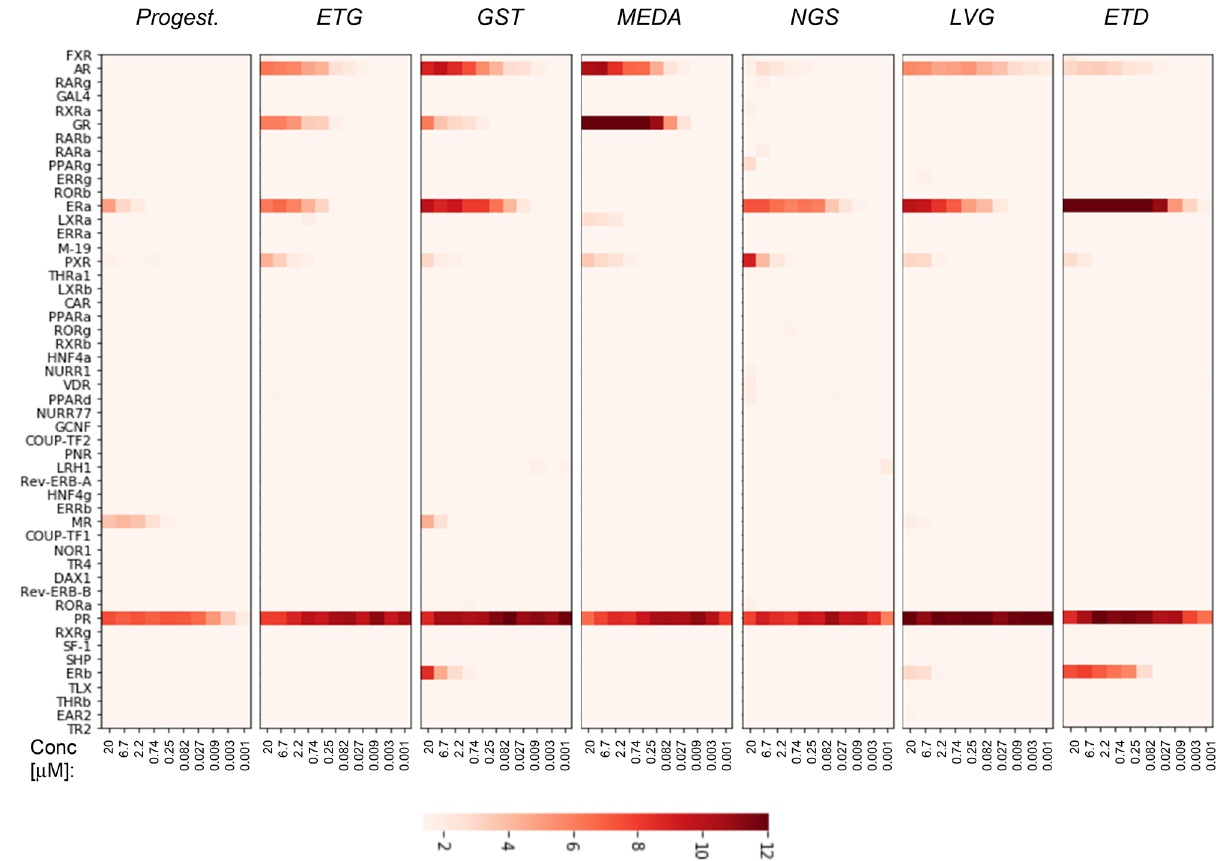
Figure 5. Assessing the polypharmacology of progestins. The heatmap shows NR activity profiles for progestins after a 24 h incubation with indicated concentrations. The fold-induction NR activity values in progestins vs. vehicle-treated cells are shown. Progest. progesterone; ETG etonogestrel, GST gestodene; MEDA medroxyprogesterone acetate; NGS norgestimate; LVG levonorgestrel; ETD ethynodiol diacetate; PRG